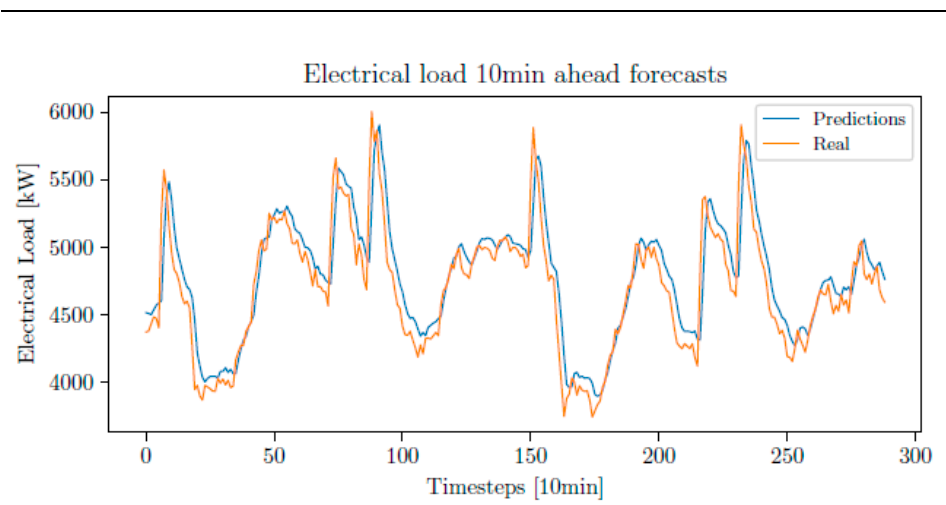
Figure 8. Ten-minutes-ahead initial forecasts.